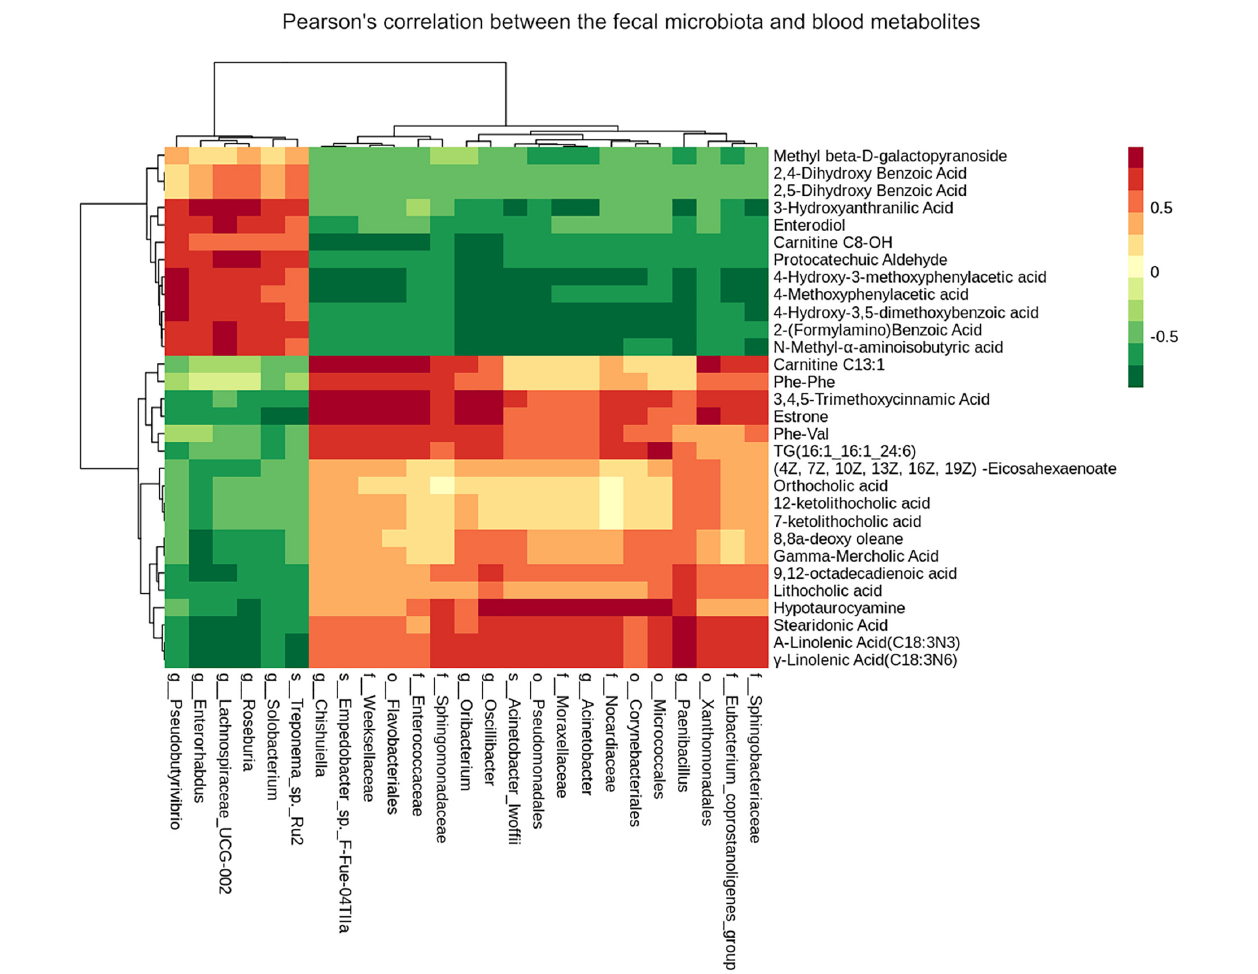
FIGURE 5 | Heatmap of Pearson’s correlation between the fecal microbiota and blood metabolites significantly different between groups is illustrated. Red represents significantly positive correlation ( P < 0.05), green represents significantly negative correlation ( P < 0.05) and yellow represents that the correlation is not significant ( P >